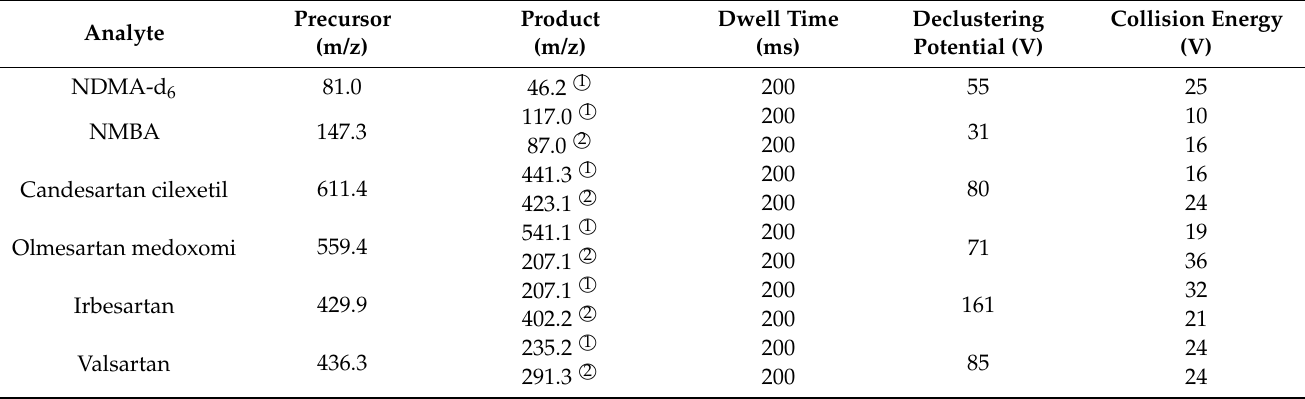
Table 1. Parameters of the multiple reaction monitoring mode.